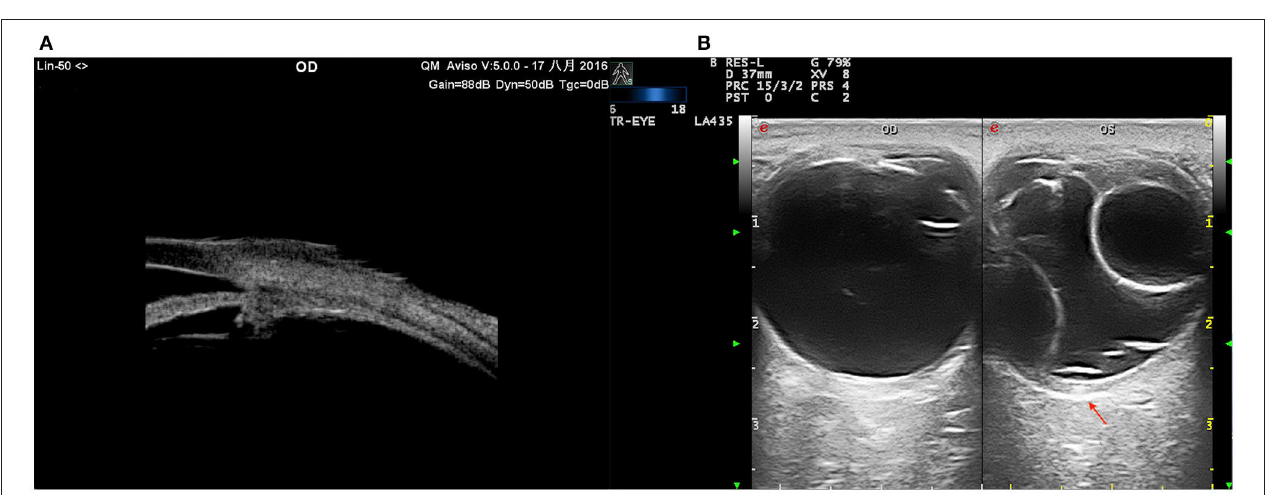
FIGURE 7 | UES in type 2. (A) UBM examination showing effusion of the ciliary body and thickened sclera. (B) CDU (TomTec Imaging System, Germany): annular bullous choroidal detachment, remarkably thickened sclera (red arrow).